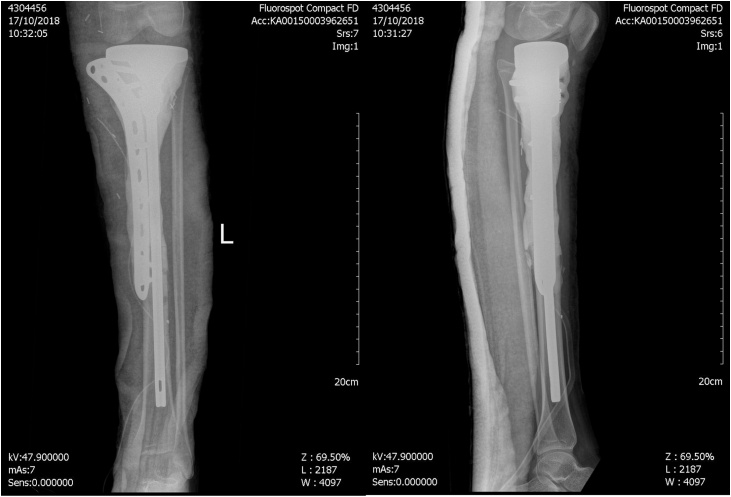
Post operative xray.